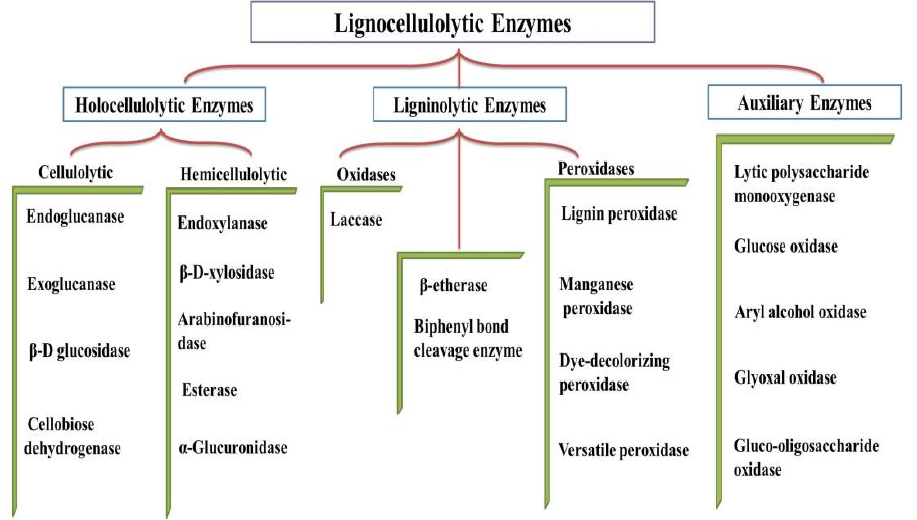
Figure 1. Different lignocellulolytic enzymes involved in the degradation of lignocellulosic biomass.